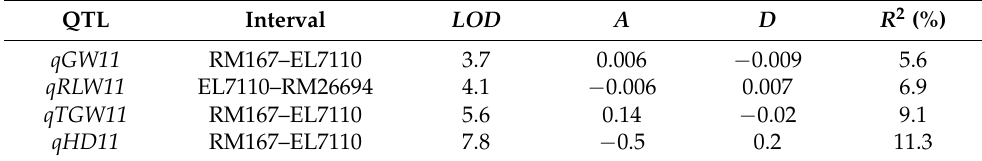
Table 4. QTLs detected in the ZL2 population.